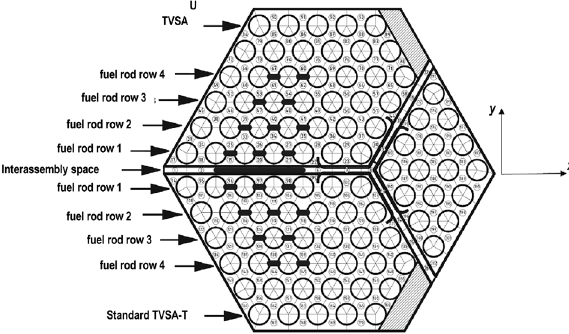
Figure 3. Arrangement of representative gaps in the TM